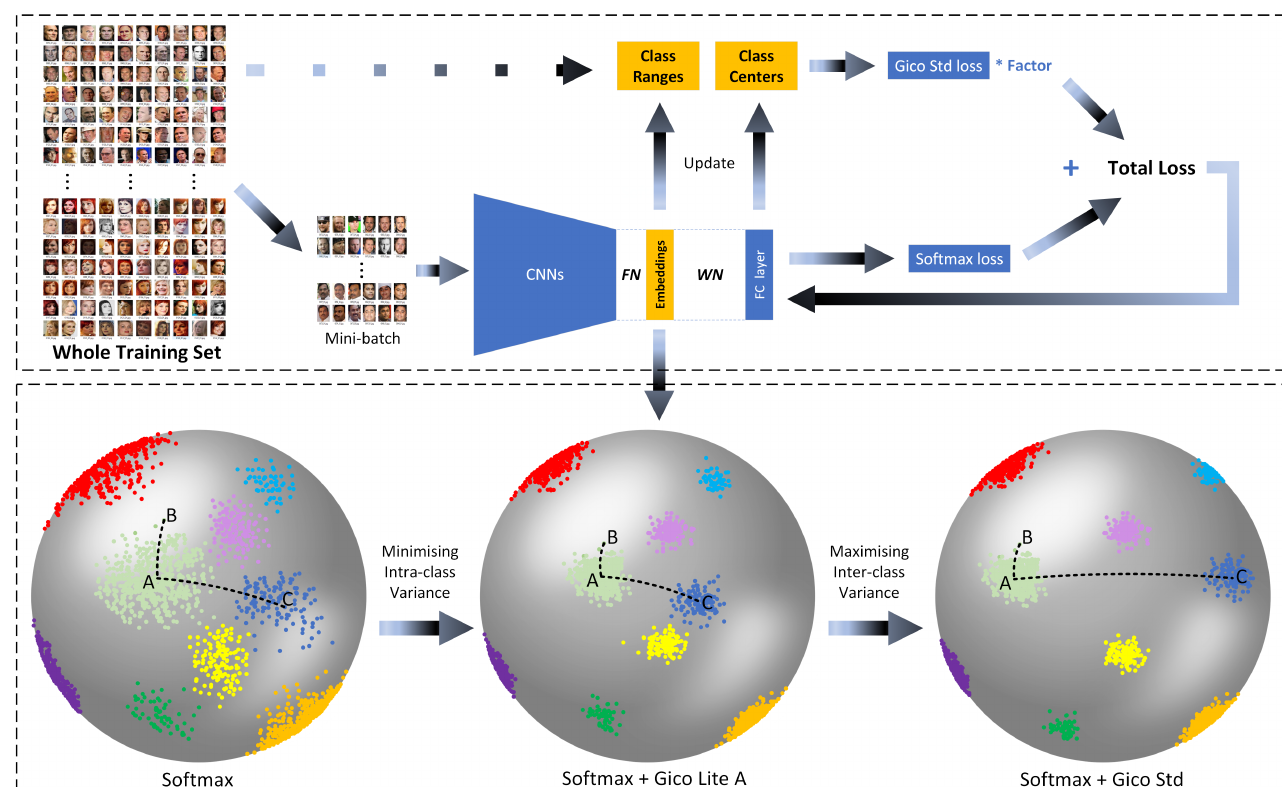
Figure 1. An overview of the proposed training framework. FN and WN represent feature normalization and weight normalization , respectively. FC layer is the abbreviation of fully connected layer. A and C are the class centers of the corresponding classes. AB represents the class range and AC represents the distance between two class